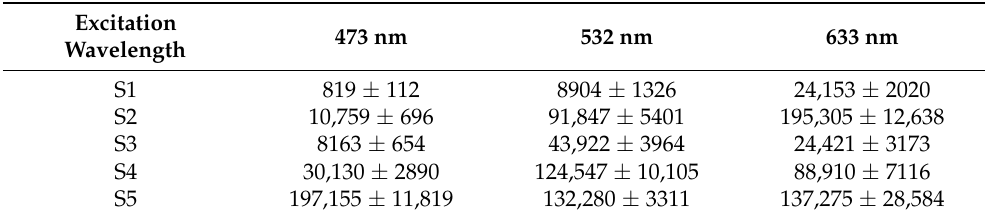
Table 4. EF values of S1–S5 were calculated for the ~1650 cm − 1 peak at different excitation wavelengths.